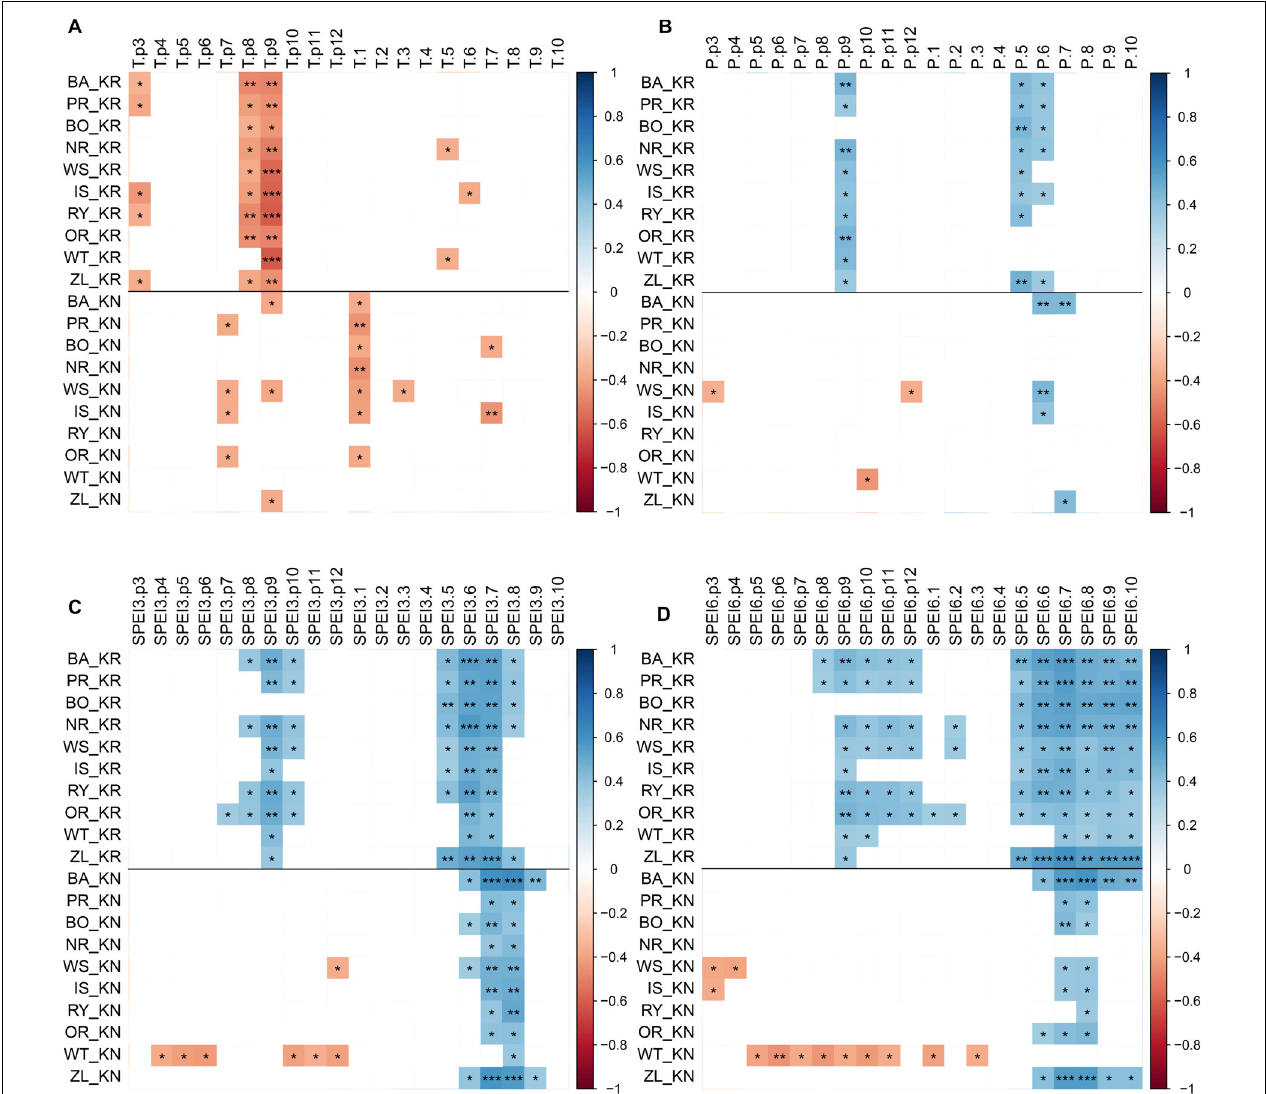
FIGURE 8 | Correlations of the RWI provenance chronologies with monthly climatic parameters, previous year March through current year October: temperature (panel A ), precipitation (panel B ), SPEI3 (panel C ), SPEI6 (panel D ) over the period 1981–2014 at the two sites: KR, KN. Colors represent correlation coefficient, non-significant correlations are not represented (white), ∗ , ∗∗ and ∗∗∗ demarcate a significance level of correlation ( p < 0.05, p < 0.01 and p < 0.001,